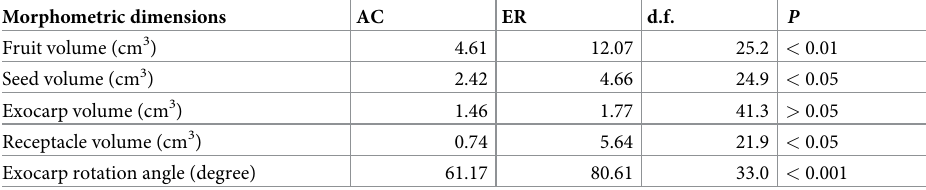
Table 2. The comparison of morphometric dimensions between the two fruit